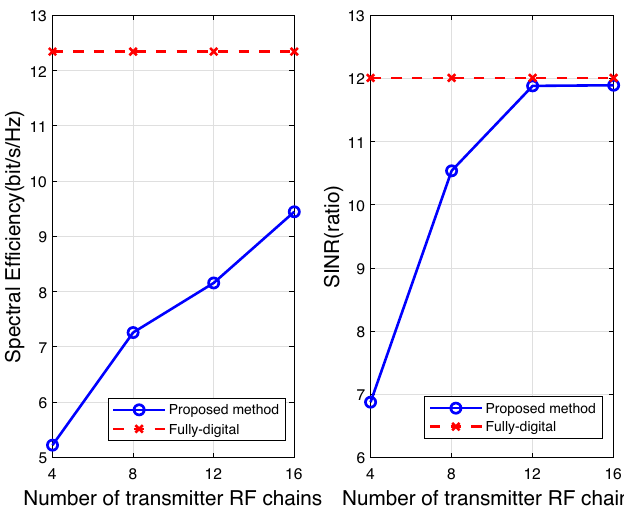
Fig. 9 The spectral efficiency and radar SINR versus the number of RF chains with N t = 64 , U = 4 , N rr = 32 , 4 , η = 0.5 and SNR = 0 N RF r =